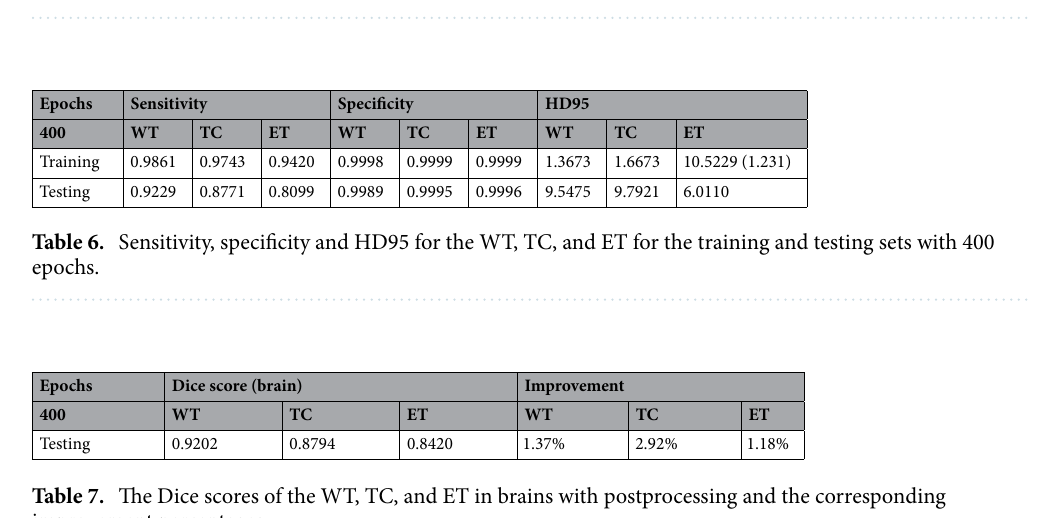
Table 5. The Dice scores of the WT, TC, and ET in the cubes and brains in the training and testing sets with 400 epochs.